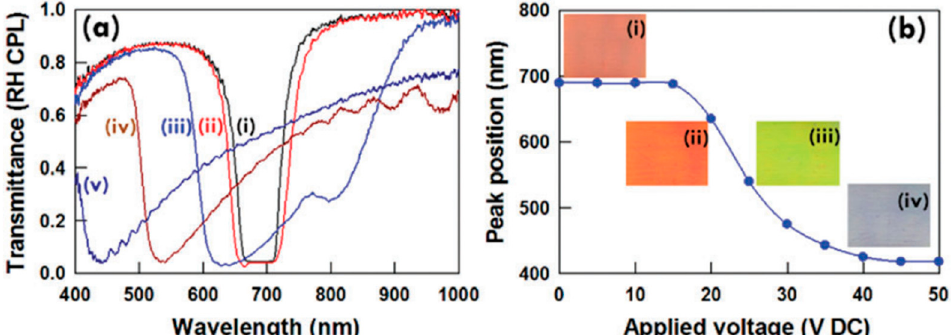
Figure 3. ( a ) Blue shifting of the selective reflection of a 15 µm thick PSCLC at (i) 0 V, (ii) 15 V, (iii) 20 V, (iv) 25 V, and (v) 35 V. ( b ) The wavelength of the selective reflection is plotted as a function of applied DC voltage. Photographs of the reflection at (i) 0 V, (ii) 19 V, (iii) 23 V, and (iv) 36 V are provided as insets. The PSCLC shown was cured at 700 mW cm − 2 for 30 min. Adapted from ref.